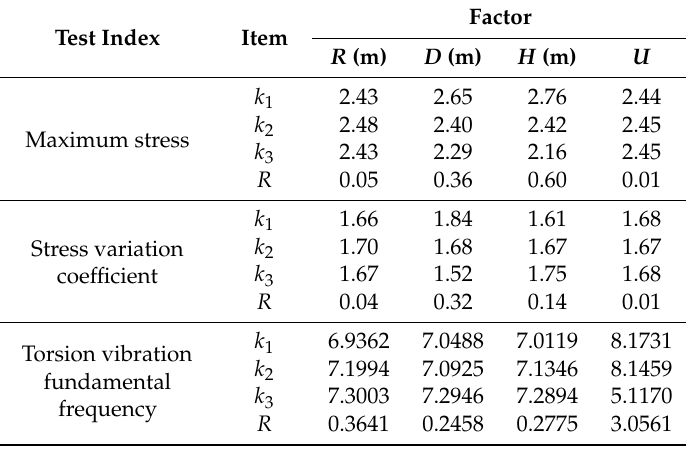
Table 8. Analysis of orthogonal test